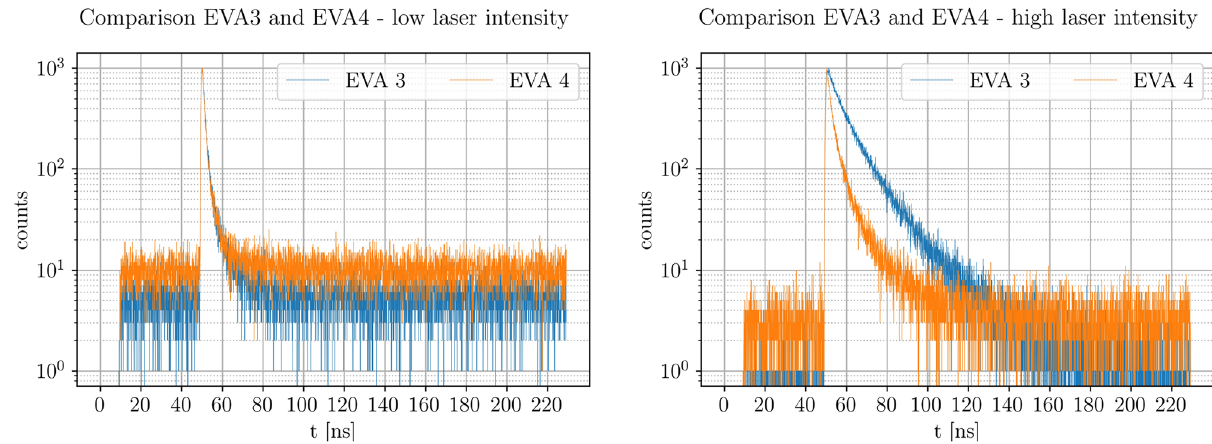
Figure 5. Comparison of TRPL measurements of Eva 3 and Eva 4 with low laser intensity ( 0, 001 · I 0 , left) and high laser intensity ( I 0 , right). The incident beam was focused on the absorber top side, which was also the area of photon detection. Attenuation of the laser intensity to 0, 001 · I 0 was made possible by using a neutral gray